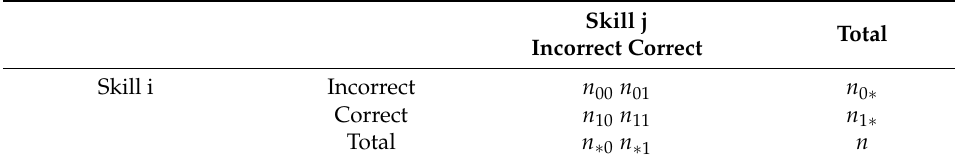
Table 3. A contingency table for two skills: i and